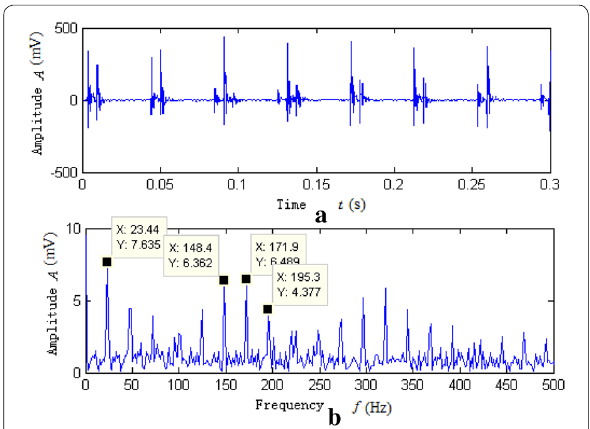
Figure 20 Low frequency component of N205 with the severe defect on the inner race: ( a ) time waveform, ( b ) local spectrum